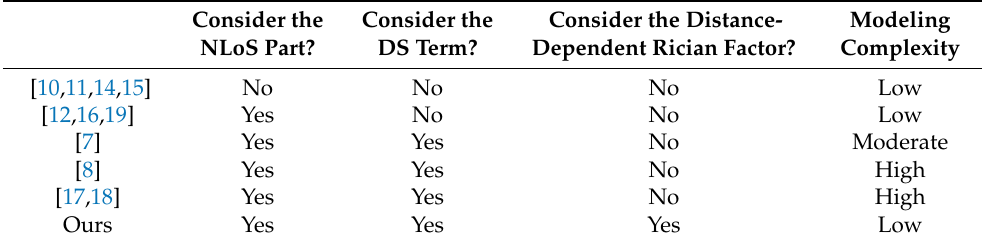
Table 1. State-of-the-art time-varying RIS-assisted HSC